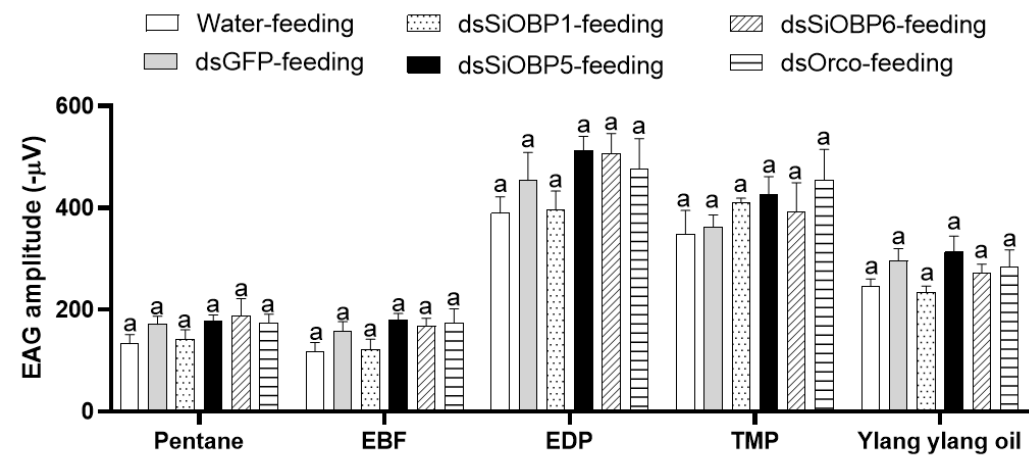
Figure 3. The EAG responses of fire ant workers to pentane, EBF, EDP, TMP, and ylang ylang oil 72 h post feeding with sucrose water, dsGFP, dsSiOBP1, dsSiOBP5, dsSiOBP6, and dsSiOrco. The means sharing no letter on the top of bars were significantly different, as determined by one-way analysis of variance with Tukey’s HSD test with significance set at p < 0.05.